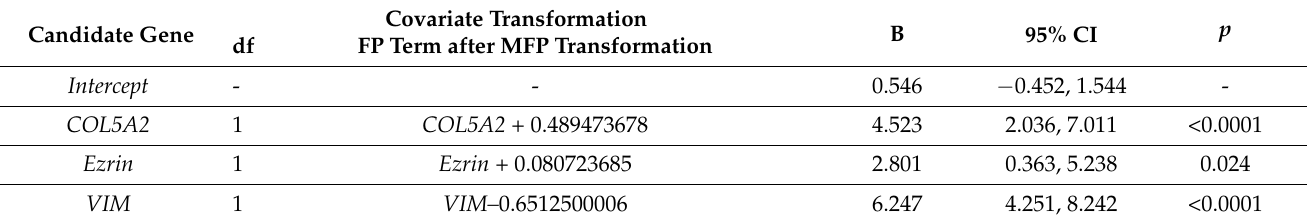
Figure 5. Locally weighted scatter-plot smoothing (LOWESS) and fractional polynomial assessment of the linear association between relative gene expression and log odds of osteosarcoma (fracplot of COL5A2 was truncated minimal value, Ezrin and VIM were truncated maximal value for visualization). Each candidate gene term is referenced in Table 3. Table 3. Multivariable fractional polynomial logistic regression model for OS diagnosis.